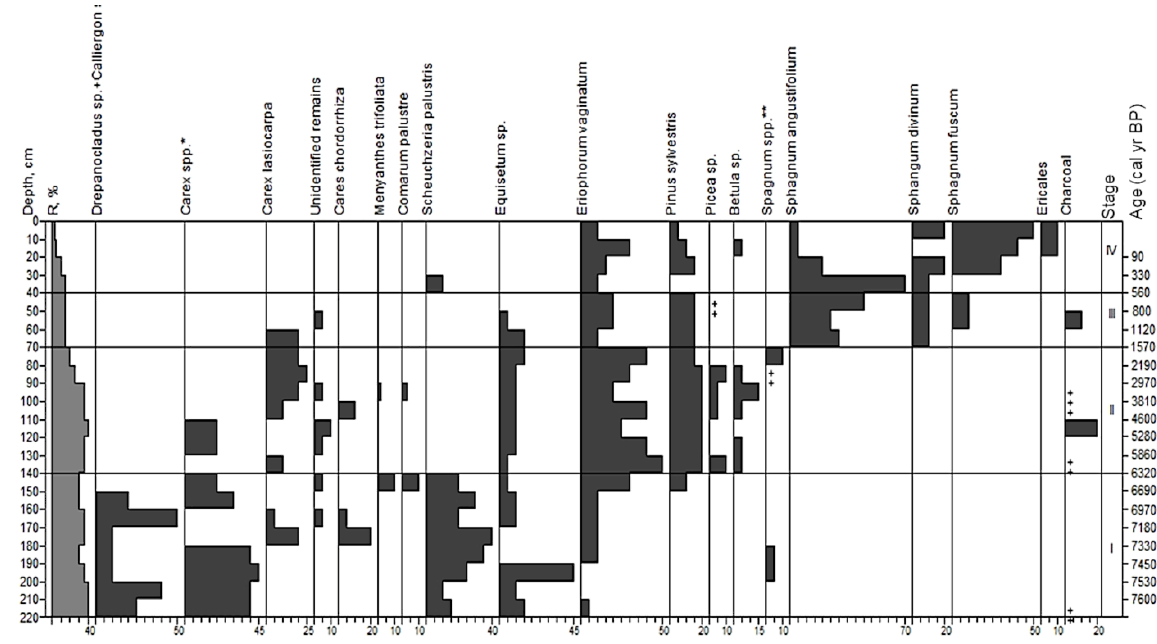
Figure 5. Macrofossil diagram for site 2. Stages correspond to paleo-communities: ( I )— Equisetum fluviatile + Scheuchzeria palustris + Carex spp.- Drepanocladus + Calliergon ; ( II )— Pinus sylvestris-Carex spp.+ Eriophorum vaginatum ; ( III )— Pinus sylvestris - Eriophorum vaginatum - Sphagnum angustifolium ; ( IV )— Pinus sylvestris-Eriophorum vaginatum - Sphagnum fuscum . * — Carex lasiocarpa + C. cespitosa + C. limosa / paupercula ; **— Sphagnum fuscum + S. divinum + S. angustifolium ; +—abundance less than 5%.